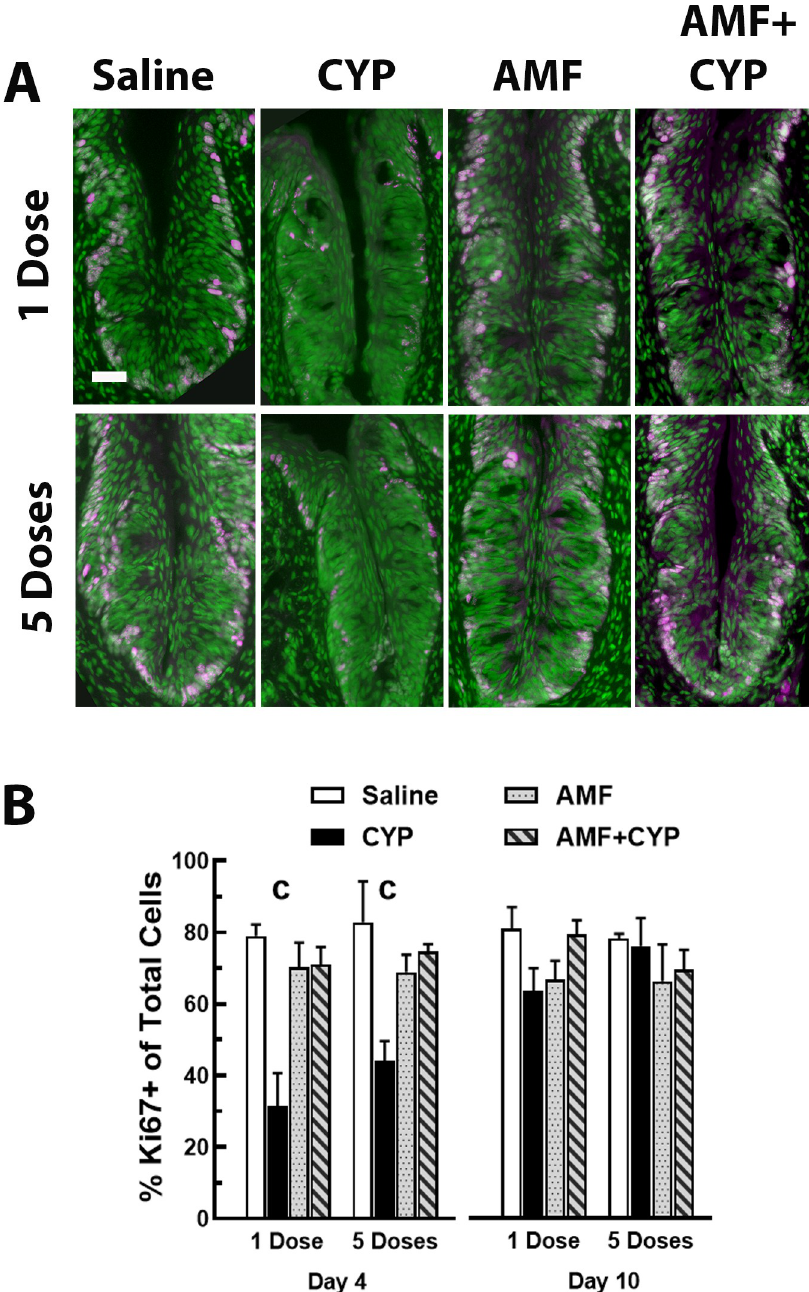
Fig 4. AMF pretreatment protected proliferating cells in the basal layer from the effects of both CYP dosing regimens. (A). Ki67+ cells (magenta) in circumvallate papillae after injections of saline (Saline, column 1 [left]), CYP (column 2), AMF (column 3) or AMF+CYP (column 4) at 4 days post injection. The top row images are examples of Ki67+ cells after single injection conditions and the bottom row images illustrate Ki67+ cells after five injections (fractionated dosing). Tissues were counter-reacted with Sytox green, a nuclear marker. For 1CYP and 5CYP mice, Ki67+ cells were nearly absent compared to all other conditions. Scale bar = 20 μ m. (B) Means ± SEM percent of Ki67 + cells relative to total cells in each drug condition at 4 (left panel) and 10 days (right panel) post injection. Both CYP dosing methods reduced Ki67 expression at 4 days but not 10 days post injection. AMF appeared to protect cell proliferation at both time points. Neither AMF dosing method appeared to alter Ki67 expression. All Ps < .05 or less: (1) � 5CYP < Saline, (2) # 1CYP < Saline, and (3) @ 5CYP < 1CYP.